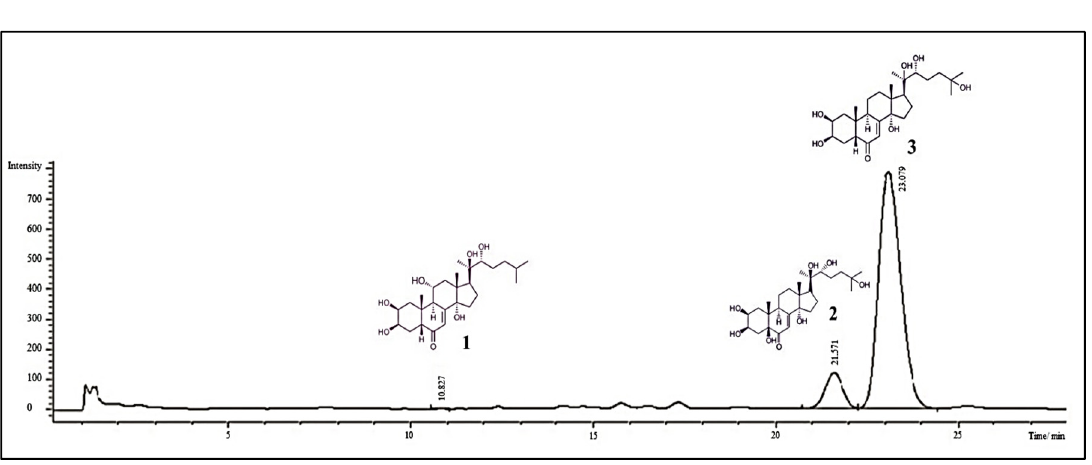
Figure 3. Chromatogram of S. coronata extract (10 mg/mL): ajugasterone C ( 1 ):less than limit of quantification (LOQ); polypodine B ( 2 ): 0.358 mg/mL (35.8 mg/g of extract); 20-hydroxyecdysone ( 3 ): 1.901 mg/mL (190.1 mg/g of extract); total compounds: 2.289 mg/mL (228.9 mg/g of extract) ≅ 22.59%.